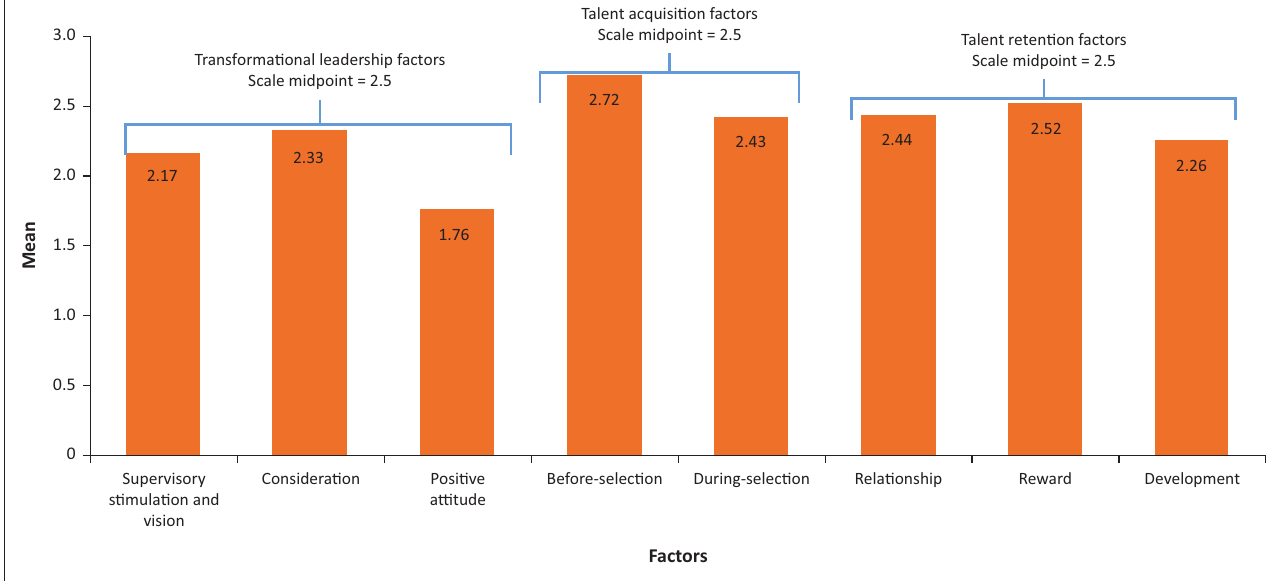
FIGURE 1: Descriptive statistics per factor. TABLE 1: Analysis of variance comparison between age groups.